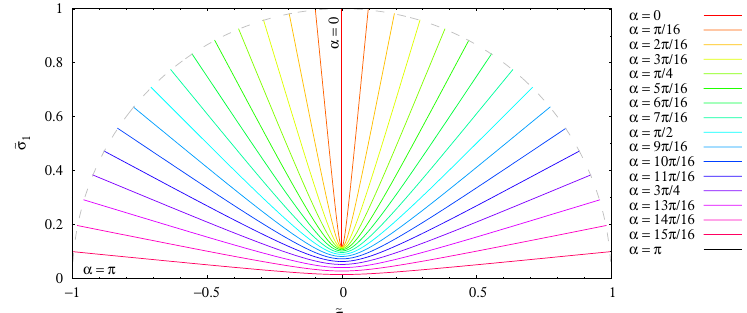
Figure 5. The functions ~ (cid:27) 1 ( x ) and ~ (cid:27) 2 ( x ) are here shown in a parametric plot. The CP N (cid:0) 1 coordinates are rotated so that the two boundaries look more symmetric, see eq. (2.31) and (cid:12)gure 1. ~ (cid:27) 1 ; 2 take values on the semicircle, i.e., points on CP N (cid:0) 1 , at the boundaries. The gray dashed line drawing a semi-circle is the numerical cuto(cid:11), where the radius is given by